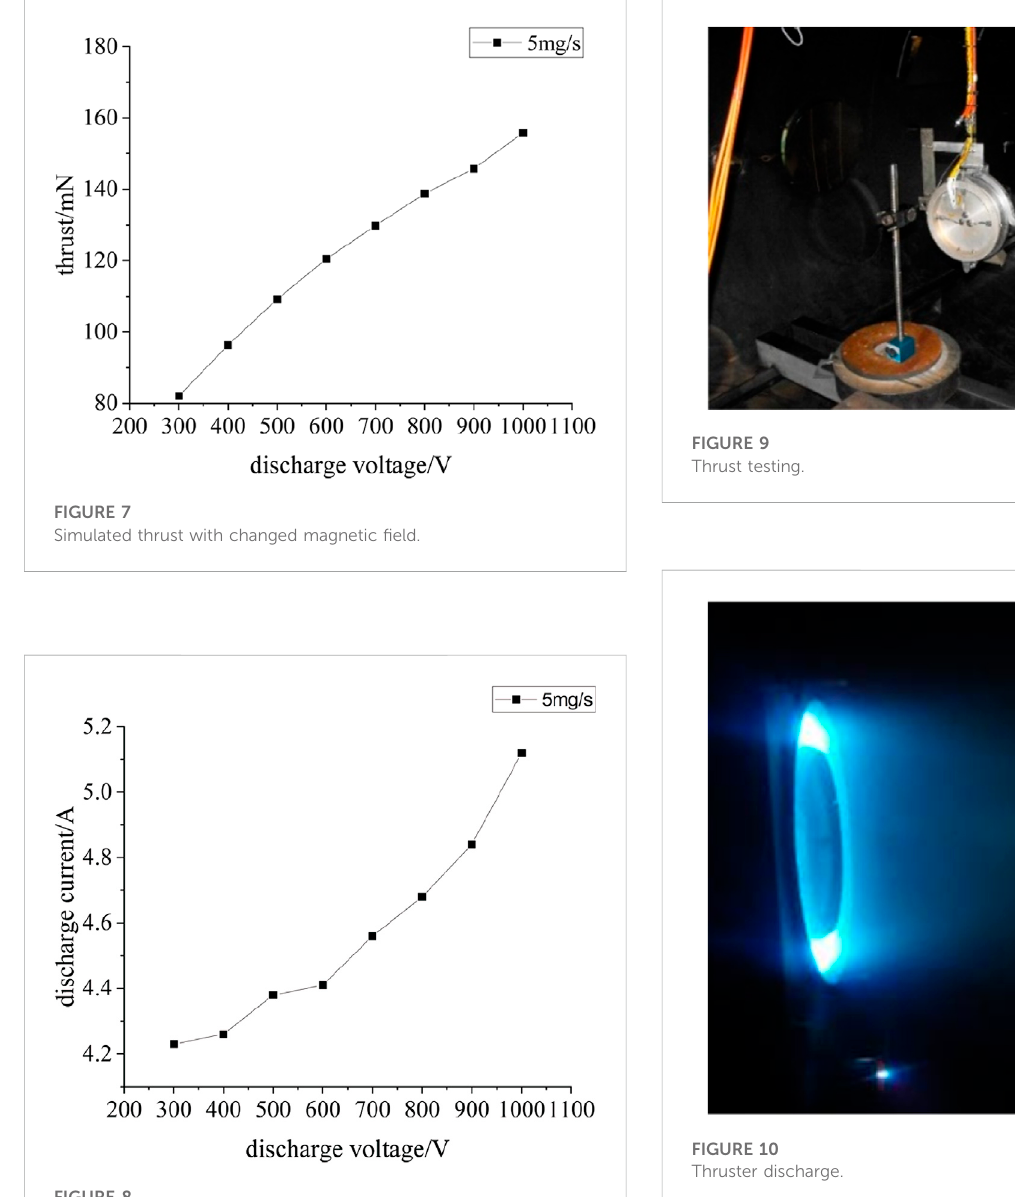
FIGURE 8 Simulated discharge current with changed magnetic fi